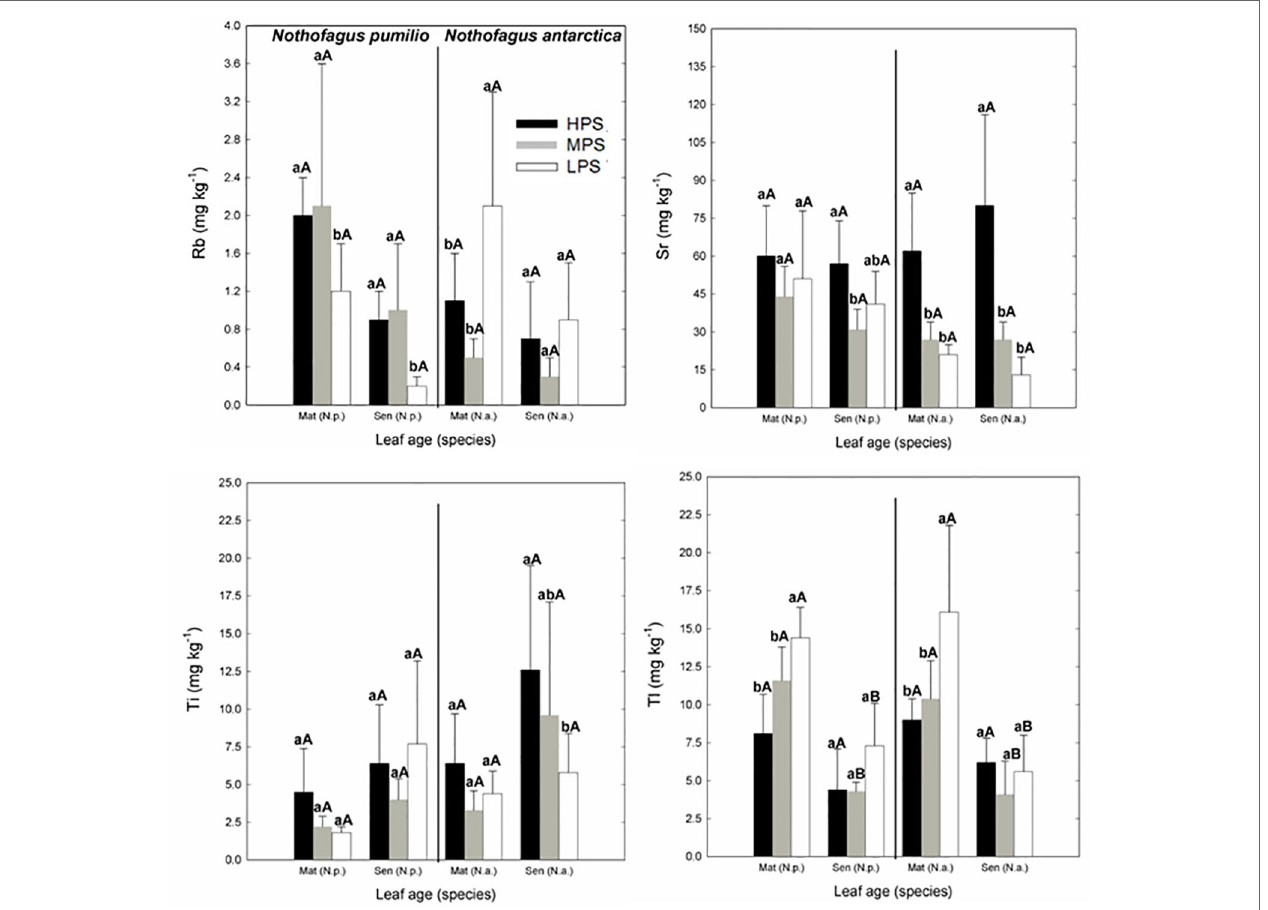
FiGURE 4 | Trace elements (Rb, Sr, Ti, and Tl) concentrations of N. pumilio and N. antarctica leaves from three contrasting sites and collected at two developmental stages (mature and senescent). HPS, highly productivity site; MPS, medium productivity site; LPS, low productivity site. N.p., Nothofagus pumilio ; N.a., Nothofagus antarctica ; Mat, mature leaves; Sen, senescent leaves. Different lower case letters for the same species and age of leaves (mature or senescent) indicate significant differences (P < 0.05) between sites. Different capital letters for the same species and site indicate significant differences (P < 0.05) between age of leaves (mature or senescent). Bars represent the standard deviation of the mean.